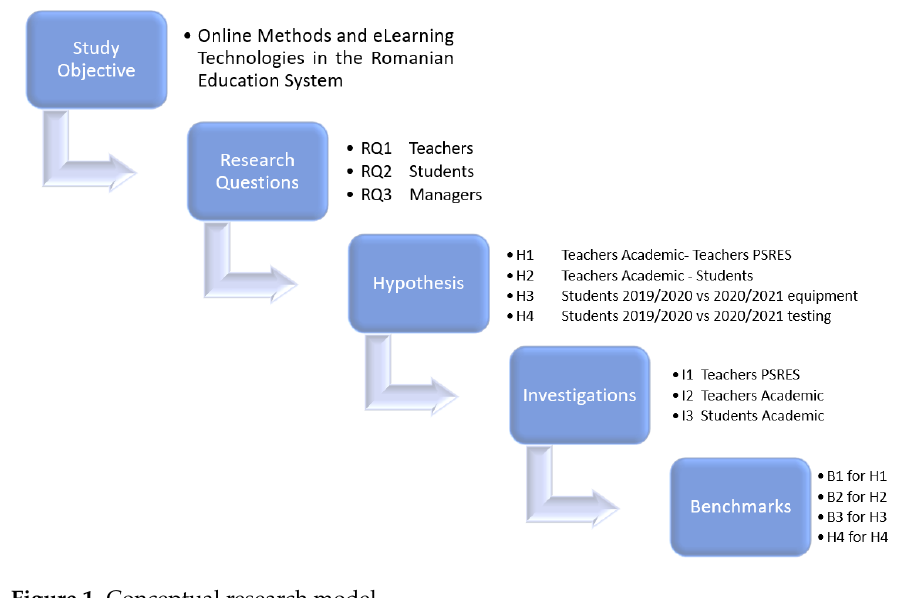
Figure 1. Conceptual research model.